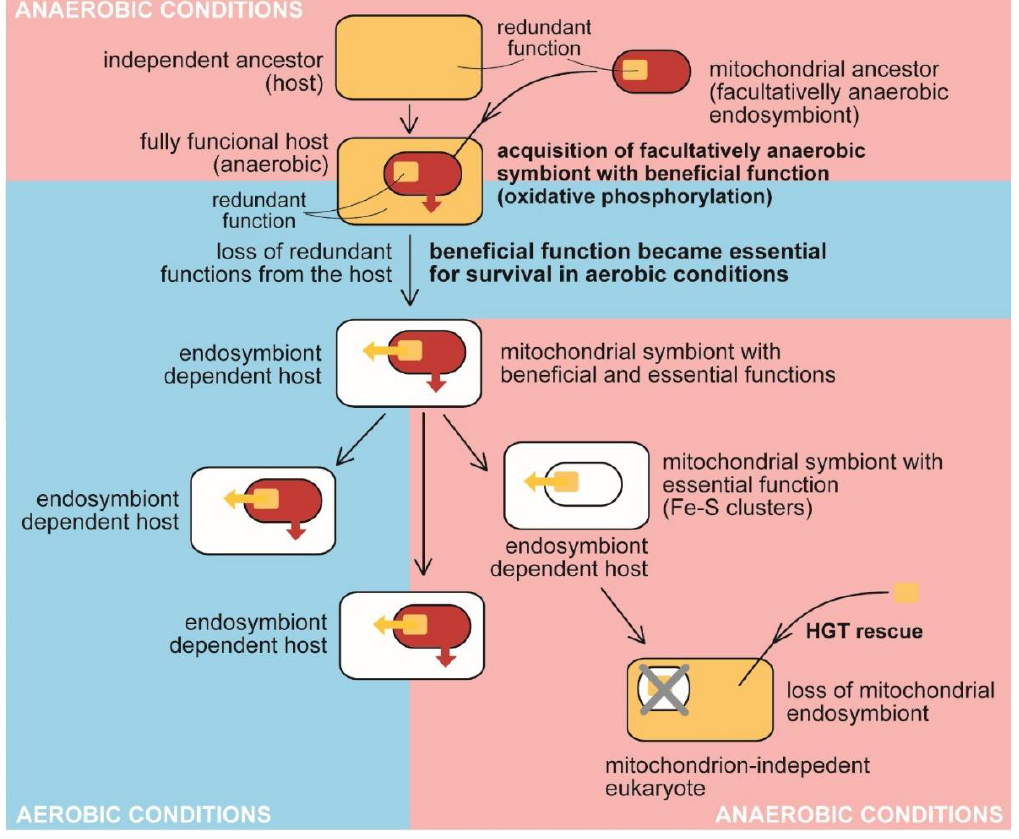
Figure 2. The traditional view on the evolution of benefit and essential function in the mitochondrion. Anaerobic host acquired a facultatively anaerobic endosymbiotic bacterium with the function beneficial for the host, presumably detoxifying oxygen. It became essential for the host in aerobic conditions. The redundant function was lost from the host (e.g., synthesis and assembly of Fe-S clusters). At the same time, the delegation of the synthesis to the endosymbiont makes it essential for host survival. The endosymbiont retained its indispensability for the host even when it had lost the original beneficial function by adaptating to anaerobic conditions. The acquisition of bacterial Fe-S clusters synthesis and assembly in the cytosol of oxymonads through HGT allowed the loss of the mitochondrion (MRO) [61].